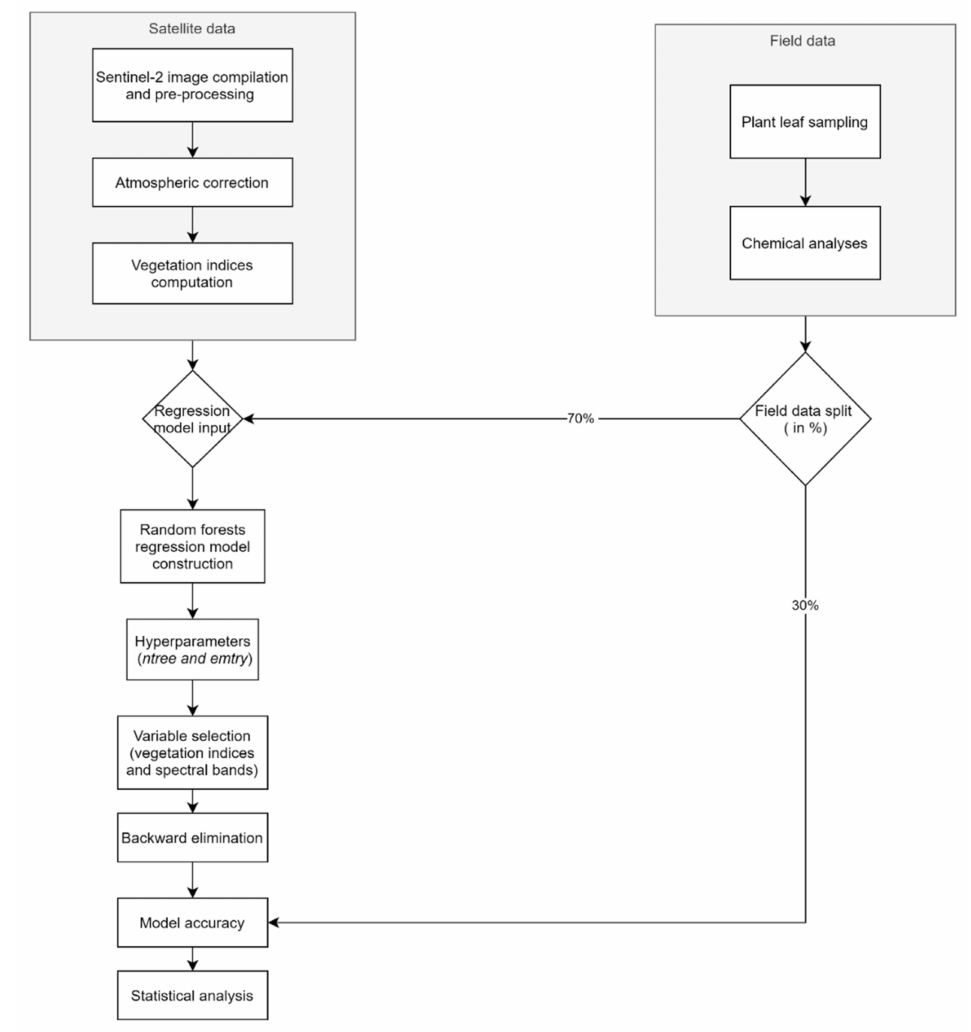
Figure 2. The flow chart summarises the overall methods for the study. Each regression tree in the RF algorithm is built using a subset of training samples that are independently selected by replacement of the original samples [88]. A subset of a few variables was randomly selected to determine the split in order to increase the robustness of the model by increasing diversity amongst trees and avoiding overfitting the model [88] and the RF predictor was finally constructed by taking the average of overall trees. The samples that are not utilised to grow the tree are referred to as Out of the Bag (OOB) data [59] which the algorithm uses to estimate accuracy by using the difference in the mean square errors to compute the OOB error estimate [71]. The explanatory power of each variable is determined by a Gini coefficient which measures the total decrease in node impurity (weighted by the probability of reaching that node) averaged across all trees. In this study, two hyperparameters were used to tune the models, that is the number of trees ( ntree ) and the number of variables randomly sampled as candidates at each split ( mtry ). It has to be pointed out that the adjustment of these hyperparameters did not significantly change the results hence these were held constant for various models considering the variability in the number of samples in stages 1 to 3 illustrated in Table